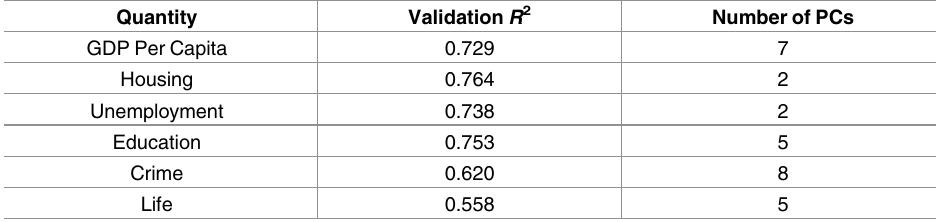
Table 1. Predictive modeling of official socioeconomic indicators based on bank big data. The predic- tion coefficientof determination( R 2 ) and optimalnumber of requiredPCs for predictingeach macro-socioeco- nomic indicatorare